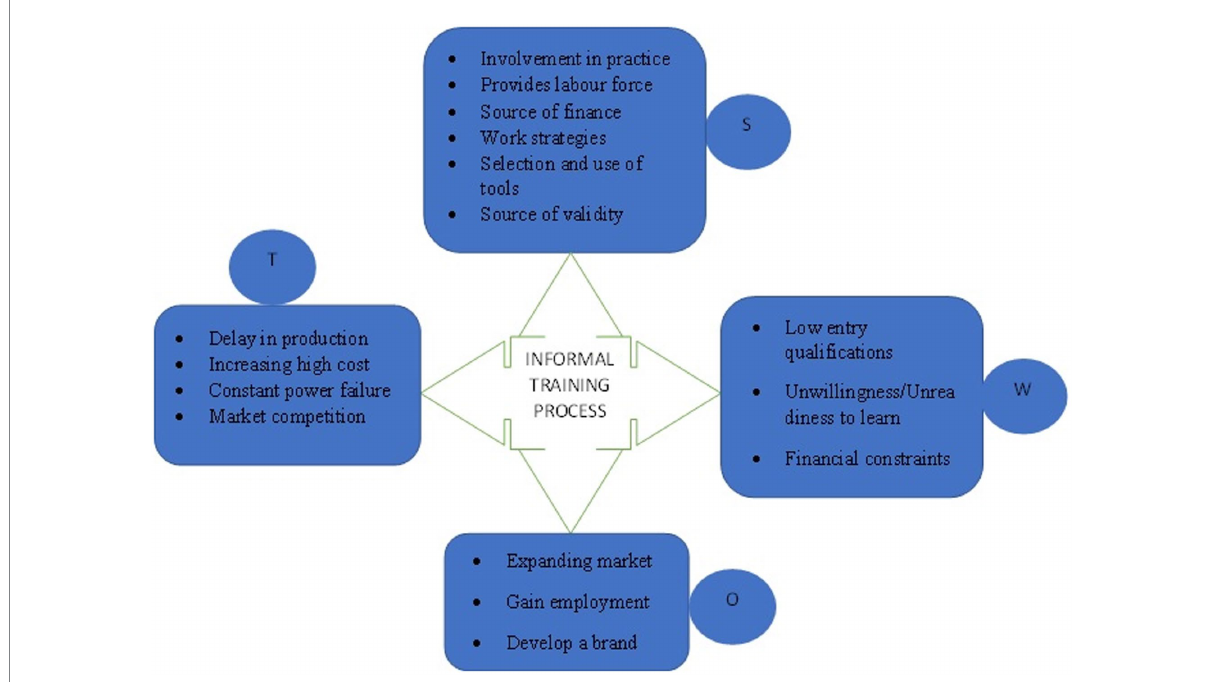
FIGURE 1 SWOT analysis of informal training and sustainable livelihoods of unemployed